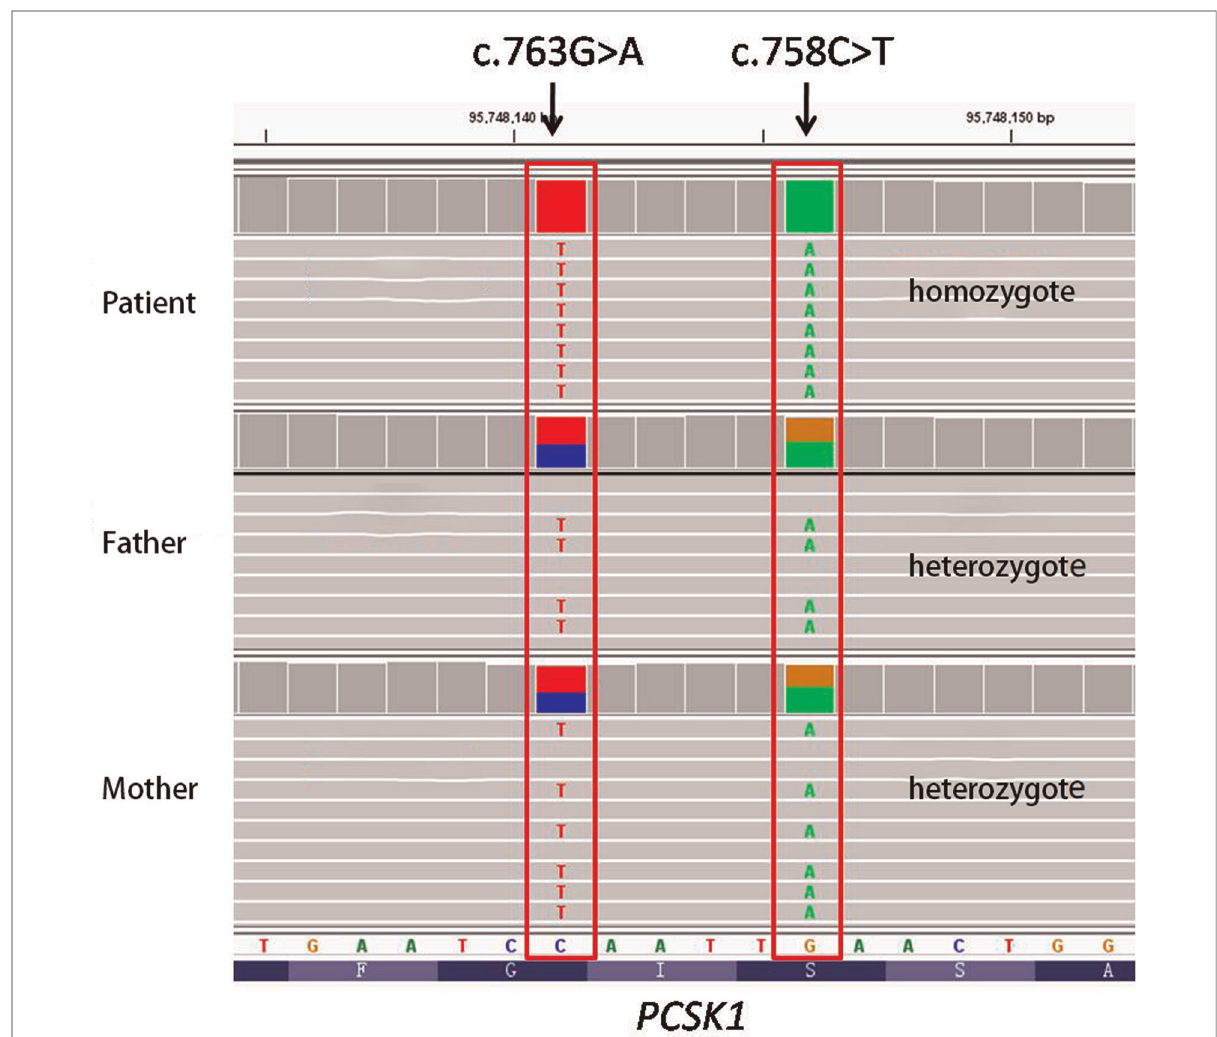
FIGURE 1 Next generation sequencing of this patient and her parents (The gene is reverse coded). NGS detected two homozygous missense mutations, c.758C >T (p.S253L) and c.763G>A (p.G255R), in exon 7 of the PCSK1 gene of this patient. Both parents are simple heterozygotes since both mutations are located on the same strand